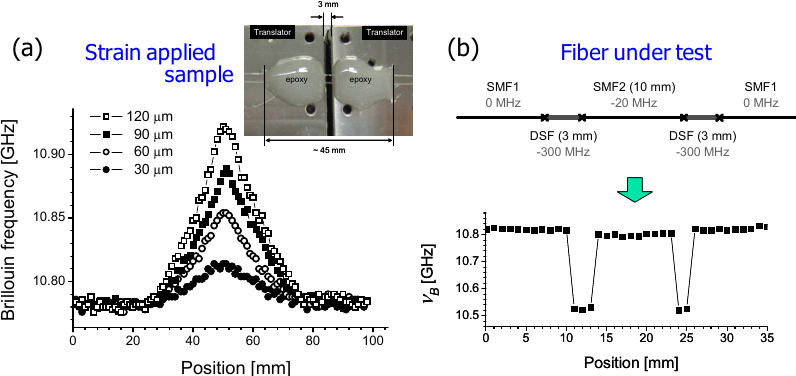
Figure 26. Demonstration of quite a high spatial resolution in the distributed BFS measurement by BOCDA with the IM scheme and the beat lock-in scheme [66]. ( a ) BFS distributions when a three-mm length of the fiber is elongated; ( b ) BFS distribution when the two three-mm short sections of a dispersion-shifted fiber (DSF) are fusion-spliced into an ordinary single-mode fiber. A 300-MHz BFS difference (6000 µε strain) is clearly measured due to the IM scheme and the beat lock-in scheme.